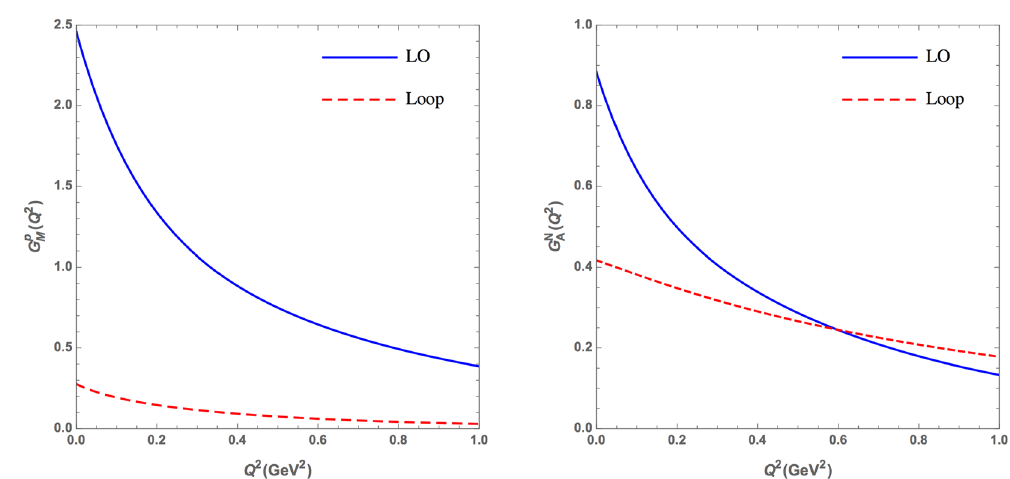
Figure 5. Leading order (solid) and loop (dashed) contributions to the proton magnetic (left panel) form factor and neutron axial (right panel) form factor.